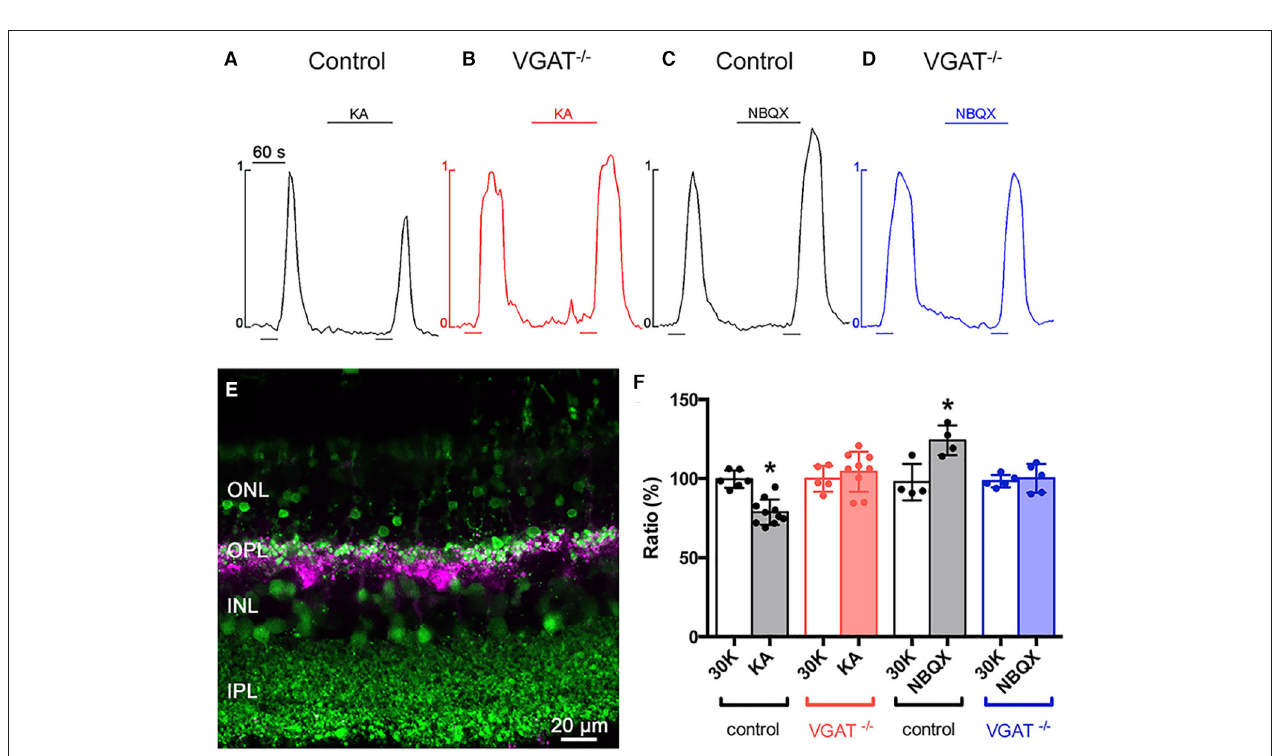
FIGURE 14 | observed. This finding indicated that the VGAT-C immunolabeling was not a result of non-specific uptake of antibody * p < 0.02. (E) Quantification of VGAT-C immunofluorescence under different extracellular Ca concentrations. Significant increases in VGAT-C immunolabeling were observed in basal (2mM) and high (10mM) [Ca 2 + ] o conditions. In contrast, little to no labeling occurred in nominally calcium-free media (0mM) * p < 0.01, ** p < 0.005. (F) Quantification of VGAT-C immunofluorescence during multiple rounds of depolarization, marked by different fluorophores (Oyster550 vs. Alexa488). Goat or donkey anti-rabbit IgG-Alexa488 recognized the VGAT-C primary antibody from the initial round of immunolabeling. In contrast when goat anti-rabbit-Alexa488 IgG was present during the subsequent incubation period in basal [K + ] o , significantly less immunolabeling was observed. Similarly, when a goat anti-mouse IgG-Alexa488 was used, little to no immunolabeling was observed **** p < 0.001. (B,B’,B”,C,C’,C, ” ) maximum intensity projections, z = 5.0 µ m. Scale bars, 20 µ m. (Modified from Lee, 2010; Vuong et al., 2011).